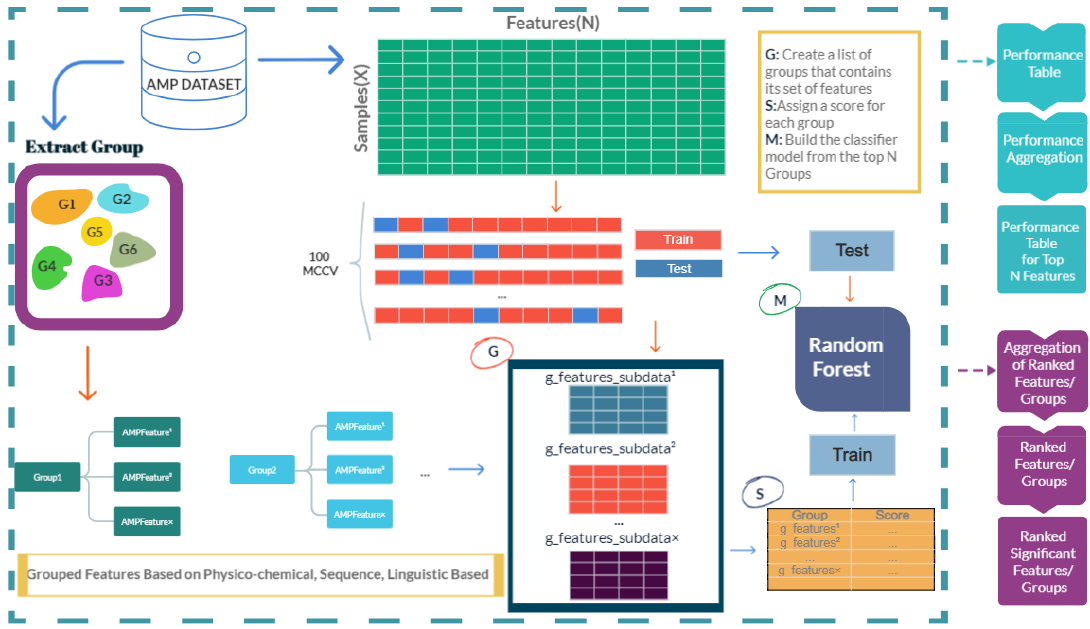
Figure 1. AMP-GSM work fl ow based on grouping, scoring, and modeling.